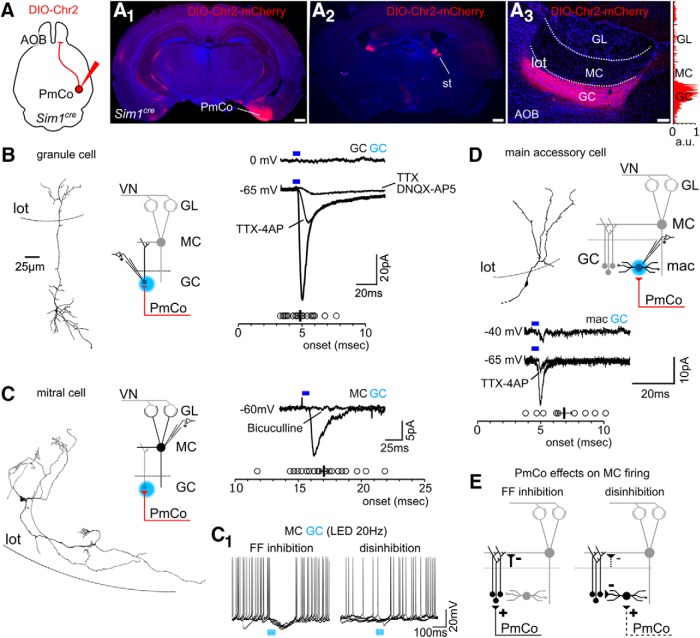
A, ACPs establish direct synaptic contact with AOB GCs. A1–A3, Injection of double-floxed ChR2 mCherry-expressing adeno-associated virus in the PmCo (A1) of Sim1cre mice results in labeling (red) of the corticobulbar circuit coursing through the stria terminalis (st; A2), and terminating in the AOB GC layer only (as shown by the color histogram on the side, A3). B, Light stimulation of PmCo afferents to the GC layer induced TTX-sensitive excitatory responses in GCs at resting potential (−65 mV; onset, 4.8 ± 0.2 ms; N = 23). These are rescued by TTX-4AP bath application, indicating direct synaptic connectivity. C, No evoked post-synaptic current (EPSCs) is detected in MCs under the same conditions, while inhibitory currents (IPSCs; onset, 17.1 ± 0.3 ms; N = 28) are visualized using a high-chloride intracellular solution. C1, Effects of repeated optogenetic stimulation of the GC layer on MC firing (five overlapped trials are shown for each effect): MC activity is either temporarily suppressed or facilitated (20 Hz light pulses, 4 ms each; frequency was compared 1 s before vs 1 s after LED stimulus onset). D, The macs receive direct PmCo inputs of lower amplitude compared to GCs. E, Circuit diagrams showing the putative effects of PmCo feedback on AOB MC firing: GC-mediated feedforward inhibition and mac–GC-mediated MC disinhibition. Above each trace, the recorded cell type and the site of LED stimulations are indicated in black and blue, respectively. a.u., Arbitrary units. Scale bars: A3, 100 μm; A1, A2, 500 μm.